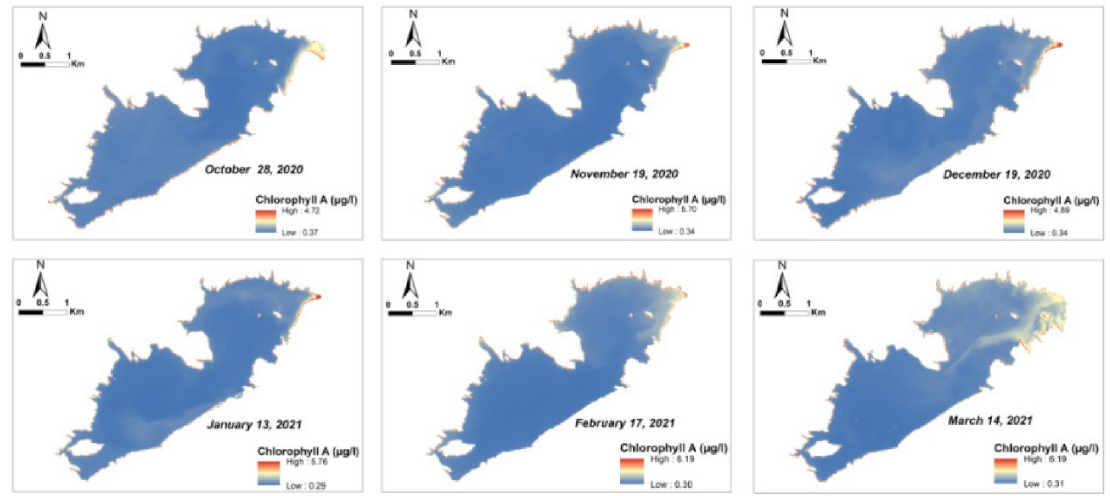
Figure 8. Obtained maps of Chl-a using best